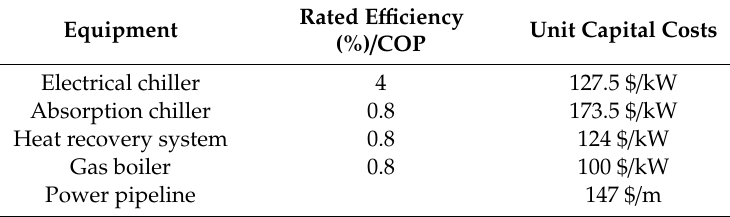
Table 4. Technical features of other equipment.